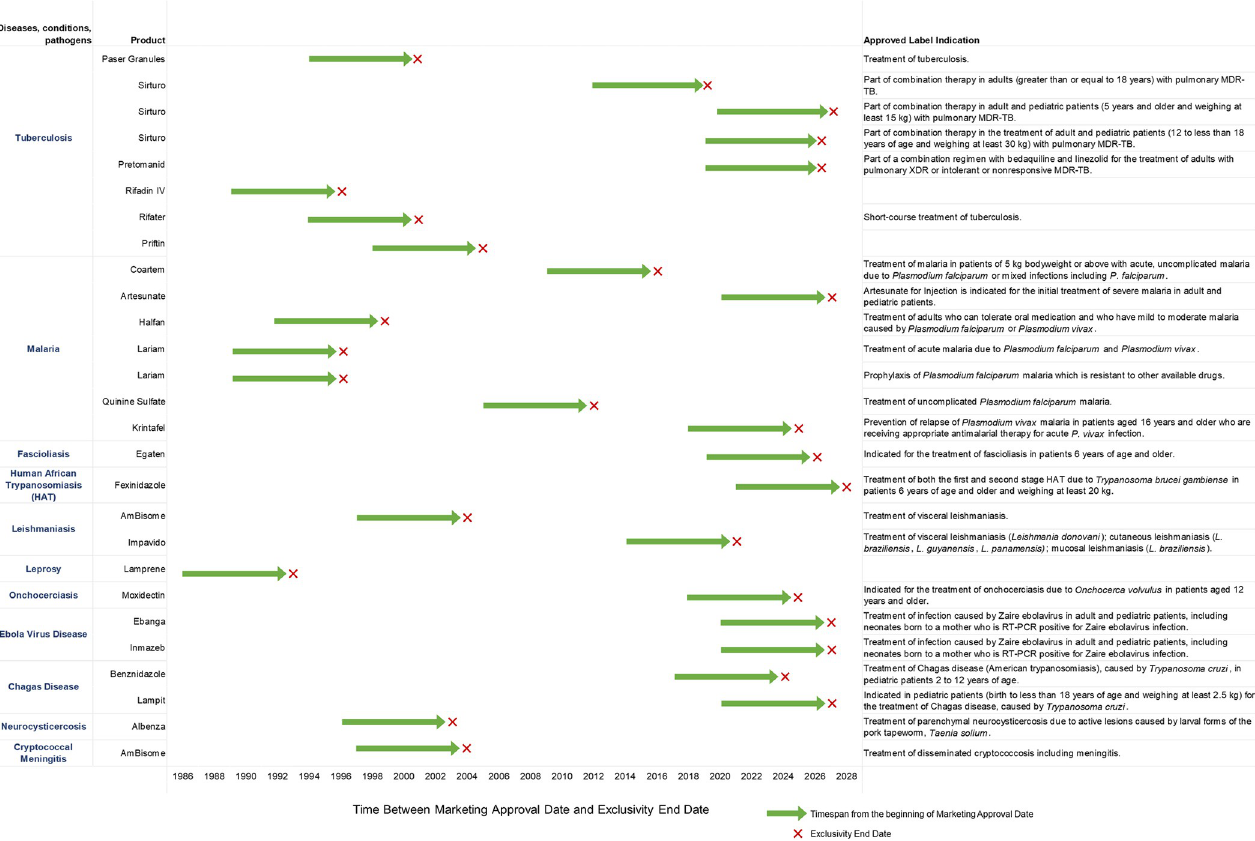
Fig 3. Tropical disease products approved under the Orphan Drug Designation Program by the US FDA. The figure shows products approved by tropical disease, the approved treatment indication, and the market exclusivity period after approval between January 1983 and July 2022. Data was extracted from FDA Orphan Drug Designations and Approvals Database (https://www.accessdata.fda.gov/scripts/opdlisting/oopd/index.cfm). FDA, Food and Drug Administration; HAT, Human African